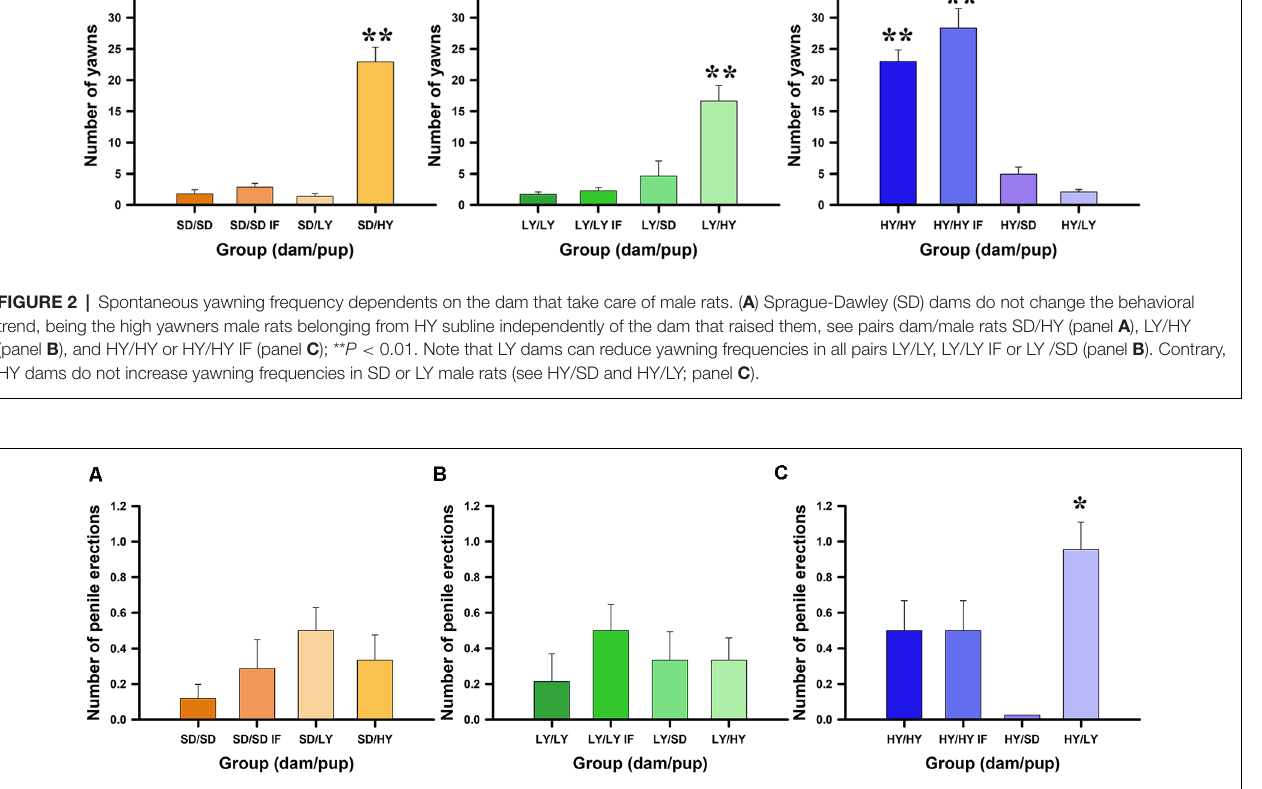
FIGURE 3 | Spontaneous penile erections dependent on the dams that take care of male rats. (A) Sprague-Dawley (SD) had similar impact across groups, rearing male rats with lower frequencies of penile erections. (B) Low-yawning (LY) dams do not change the penile erection frequencies in the different groups of male rats. (C) However, High-yawning (HY) dams are capable to increase the number of spontaneous penile erections on LY male rats (see HY/LY, * P <